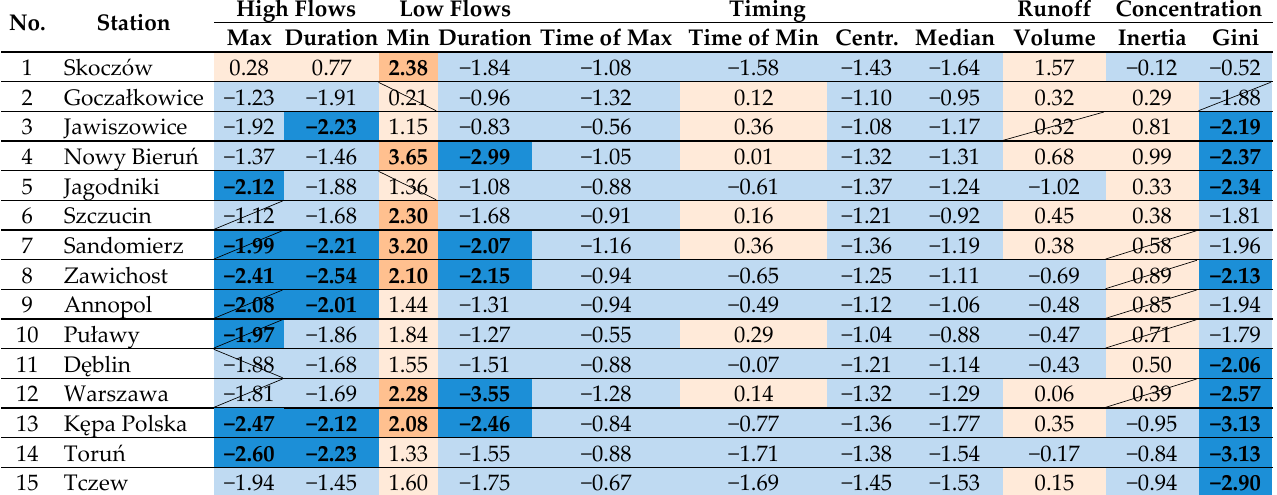
Table 5. Results of the Mann test ( uF statistics) for trends in winter season daily flow characteristics along the Vistula course; orange colour denotes positive uF values, blue colour negative. The marks represent the diagonal lines from the upper left corner to the lower right to show that the value can decrease if autocorrelation is taken into account and the opposite is true for the cases when the autocorrelation causes an increase in the presented value. Numbers in bold indicate statistically significant changes at α level 0.05.